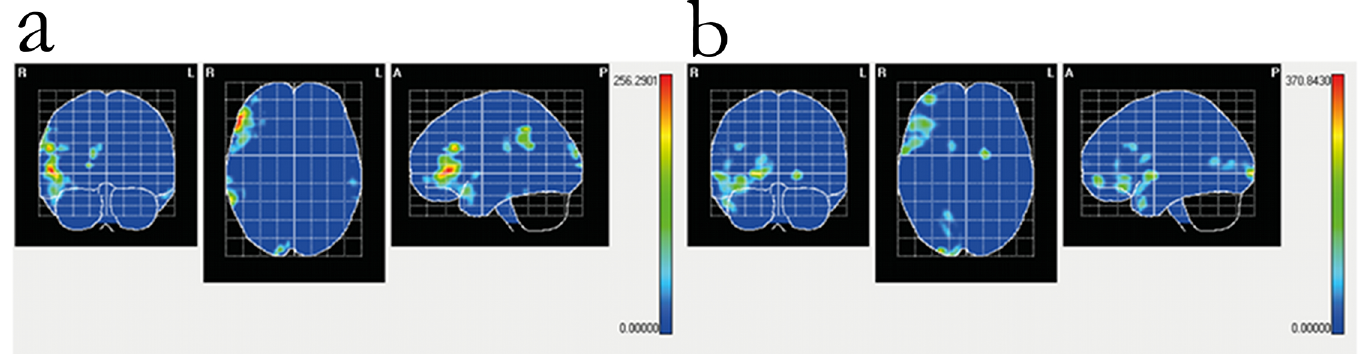
Fig 5. Statistical Mapping (SM) independent Hotelling T2 significant differences in P100 peak intensity between children with blindness and their seeing controls following presentation of non-target stimuli in the letter recognition (panel a) and line orientation (panel b) tasks. Red color represents p < .05. For description of individual anatomical areas see Table